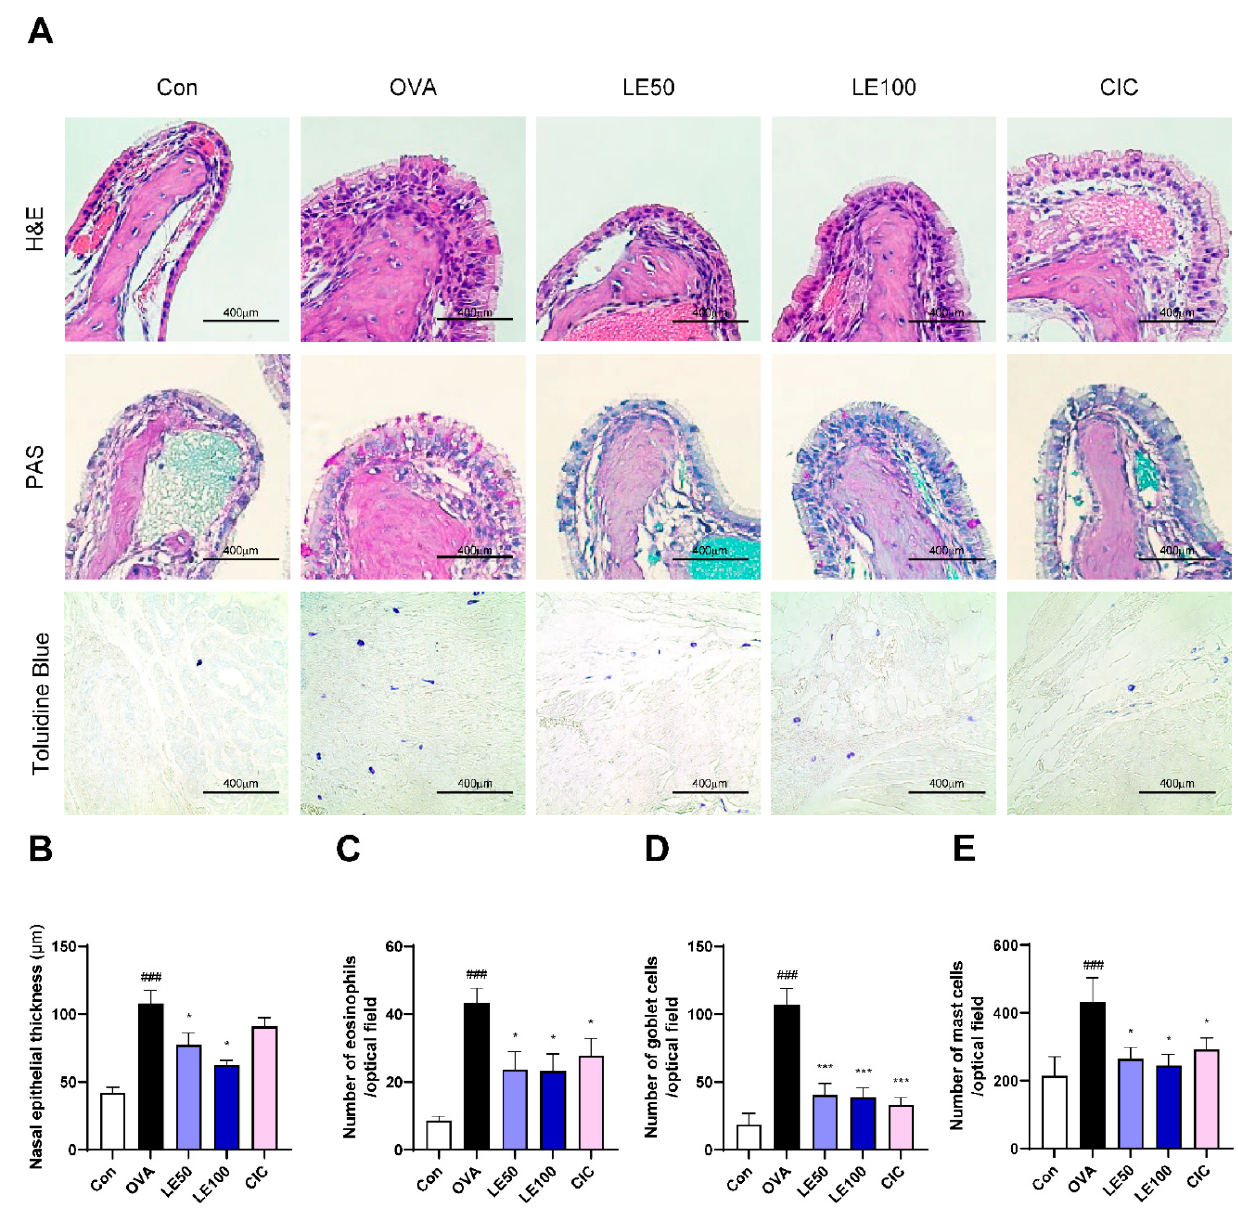
Figure 2. Effects of LE on nasal tissue histological changes in OVA-induced AR mice. ( A ) Hematoxylin and eosin (H&E), periodic acid–Schiff (PAS), and toluidine blue stains were used to evaluate the histological findings in nasal tissues from each group. Scale bars: 400 μ m. Histological sections were assessed with respect to ( B ) epithelial layer thickness (from H&E staining), ( C ) eosinophil counts in the nasal mucosa, ( D ) goblet cell counts (from PAS staining), and ( E ) mast cell counts (from toluidine blue staining). Data represent the mean ± SEM ( n = 10 per group). Significant differences at ### p < 0.001 versus the control group. * p < 0.05, *** p < 0.001 versus the OVA group.